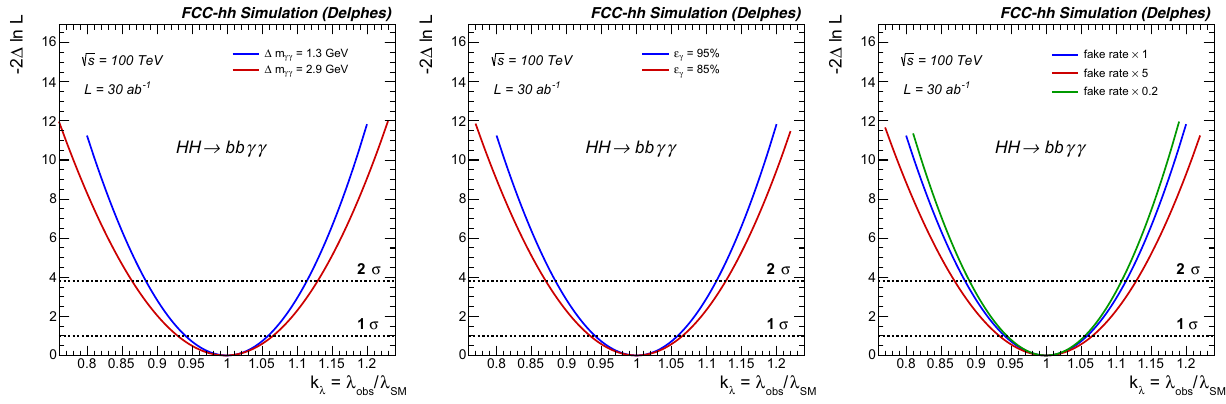
Fig. 10.5 Expected precision on the Higgs self-coupling modifier κ λ obtained by varying the photon reconstruction performance. Left: com- parisonoftwoscenarioswithnominal( (cid:4) m γγ = 1 . 3GeV)anddegraded ( (cid:4) m γγ = 2 . 9 GeV) energy resolution. Centre: Comparison of two sce-